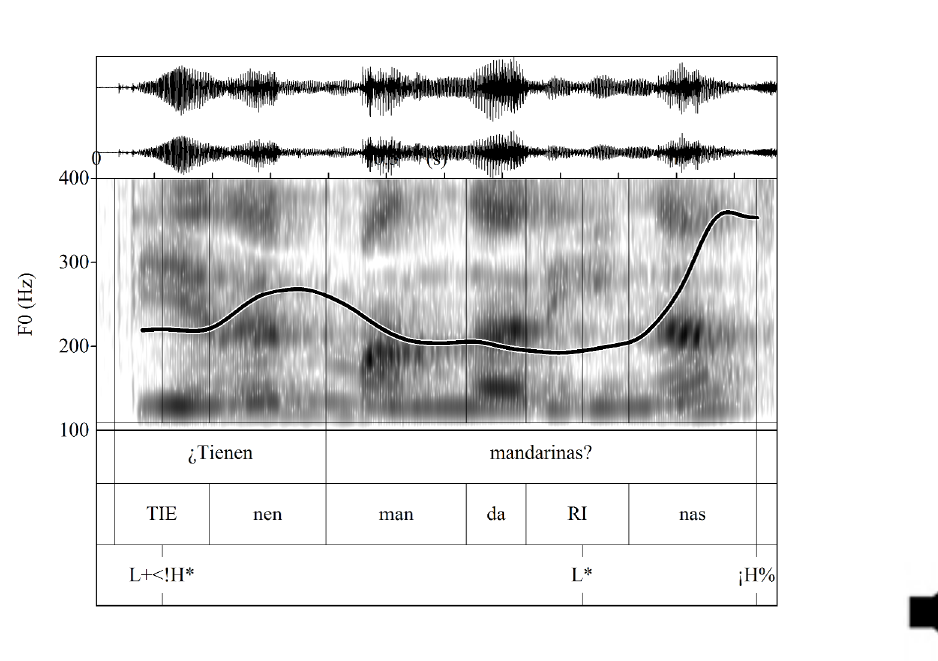
Figure 7 (Participant 3): Waveform and F0 trace for the info seeking yes-no question ¿ Tienen mandarinas? ‘Do you have tange- rines?’ produced with L+<H* (pre-nuclear position) and L* (nuclear position) followed by an ¡H% boundary tone.